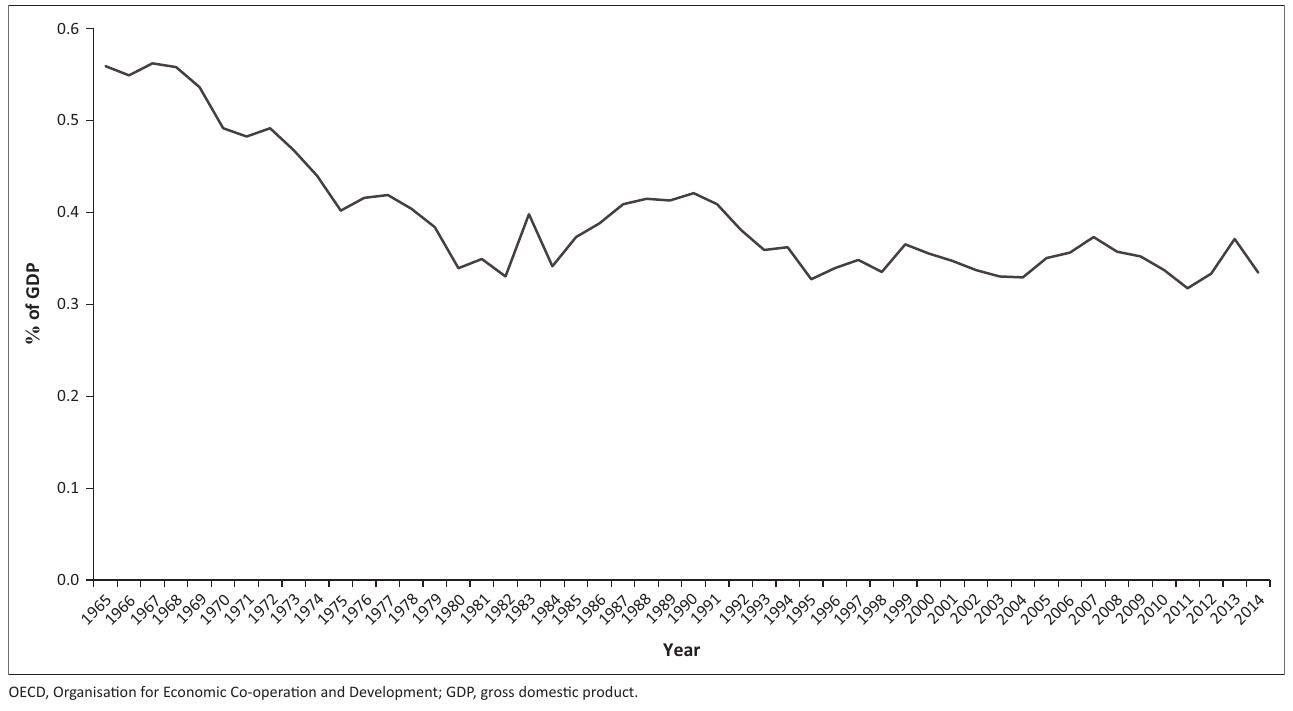
FIGURE 1: Wealth tax on individuals as a percentage of gross domestic product: OECD